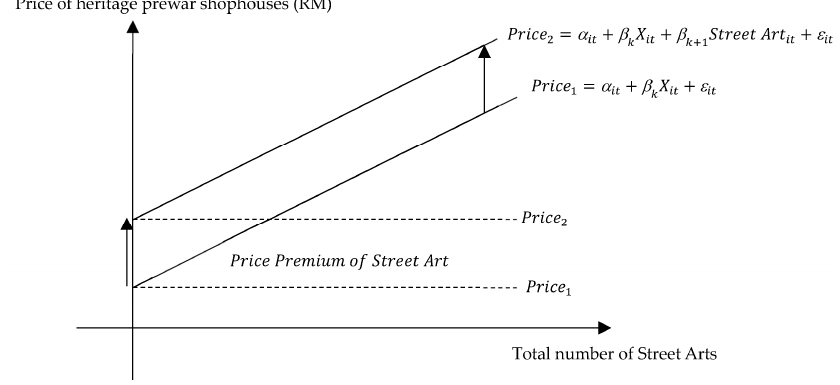
Figure 5. Illustration of Forming Price Premium of George Town’s Street Art. Model 1: Basic Hedonic Pricing Model of Prewar Shophouse